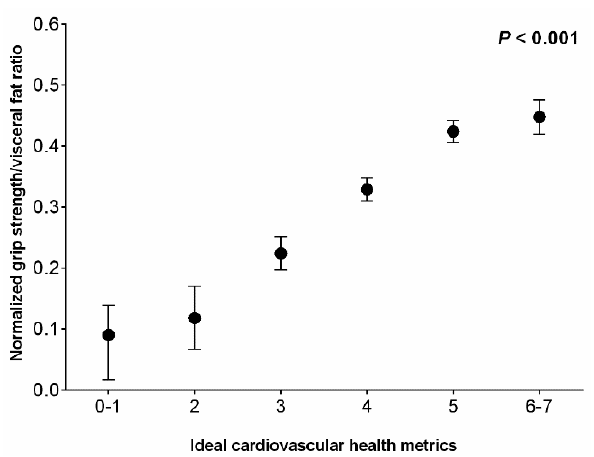
Figure 2. Association between muscular fitness (NGS) to visceral fat ratio across ideal CVH behaviors (smoking, body mass index, cardiorespiratory fitness, and Mediterranean diet adherence), ideal CVH factors (total cholesterol, blood pressure, and plasma glucose) and 7-metrics cardiovascular health in college students.